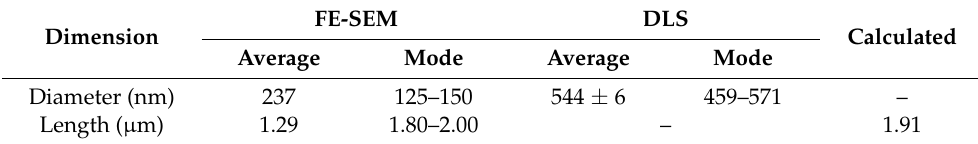
Table 1. Estimation of the dimensions (length and diameter) of